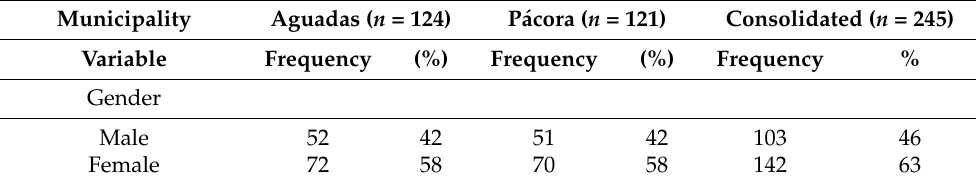
Table 2. Respondent socioeconomic information ( n =